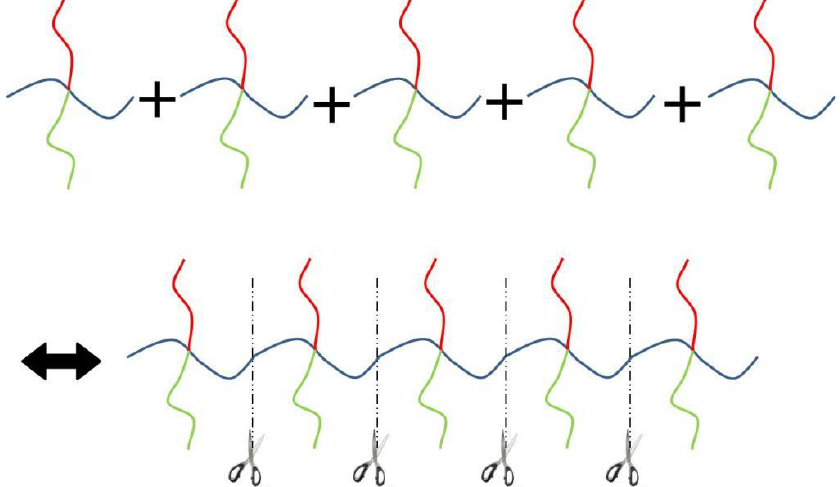
Figure 1. The Janus double-brush copolymer (AC 2 B) n contains n constituting subunits, and each subunit is a four-arm star copolymer. Here the architectural periodicity n is 5. Each AC 2 B subunit consists of one arm A chain, one arm B chain, and two arm C chains. In this plot and in the following snapshots, the segments A, B, and C are colored in red, green, and blue, respectively.